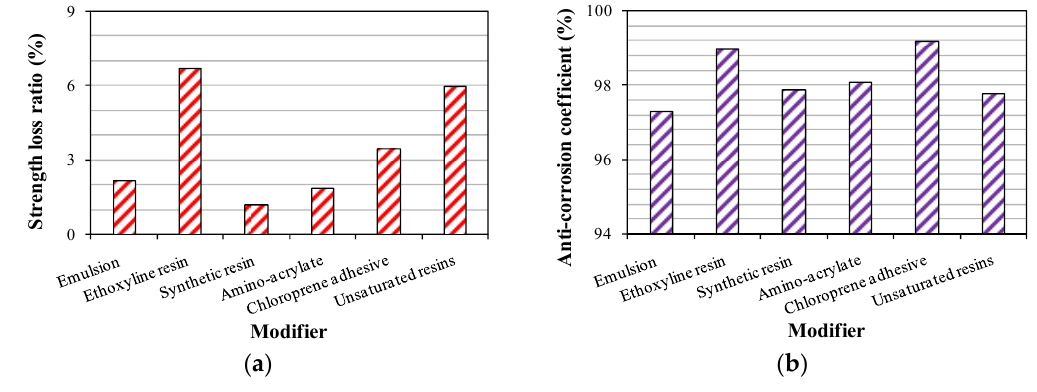
Figure 9. Durability of modified crumb rubber concrete. ( a ) Freezing ‐ thawing resistance; ( b ) sulfate resistance.